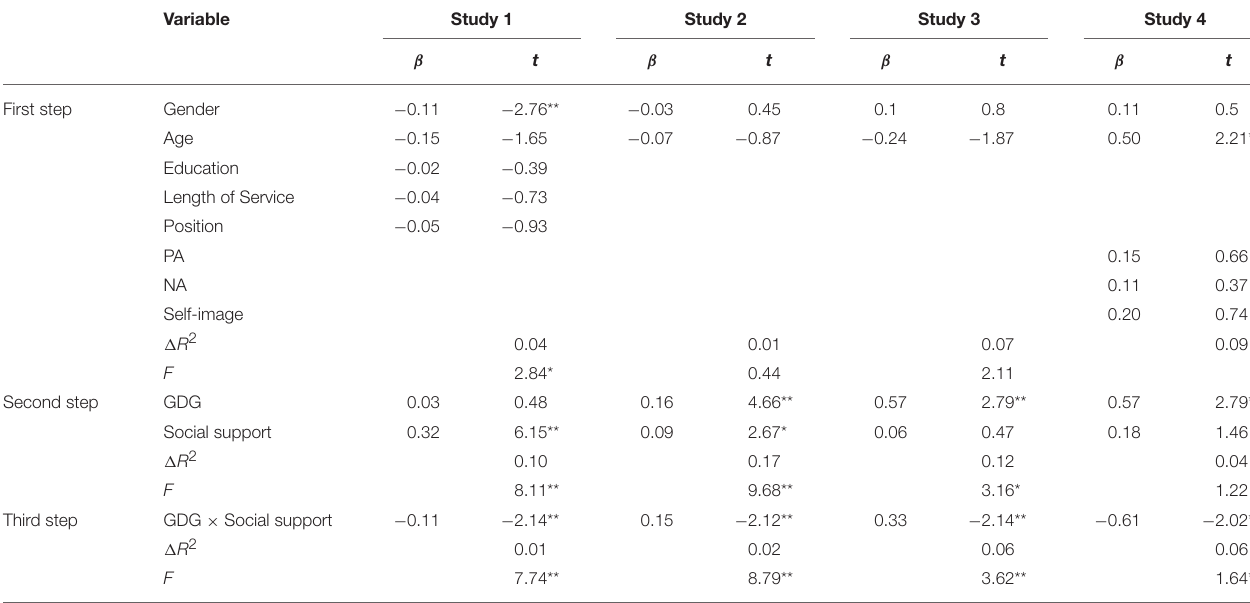
TABLE 2 | Regression analyses for Studies